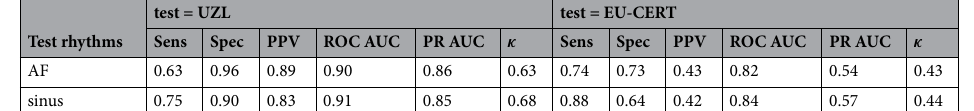
test = UZL test = EU-CERT Test rhythms Sens Spec PPV ROC AUC PR AUC